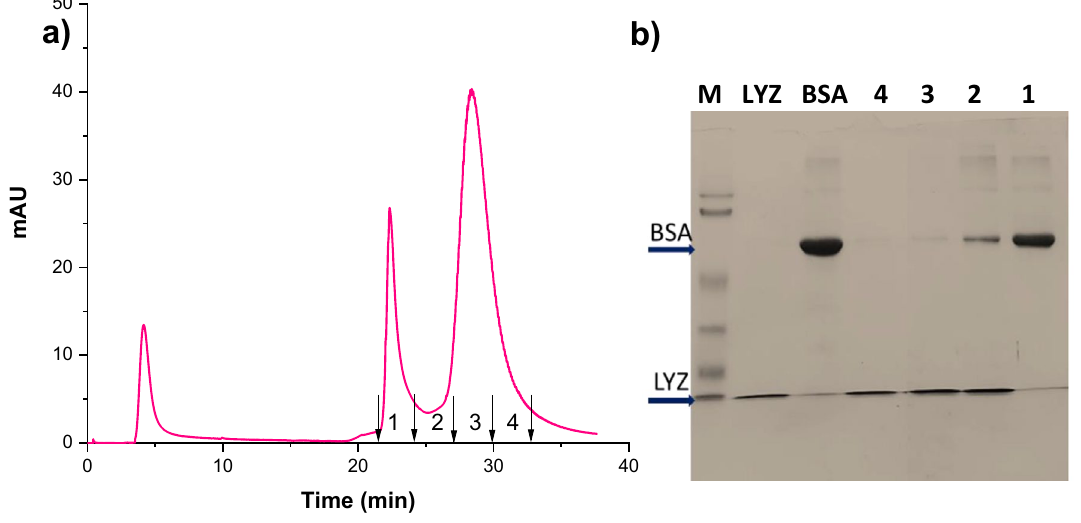
Figure 8. Isocratic elution chromatogram for the binary protein mixture of BSA and LYZ ( a ), SDS-PAGE cropped image obtained for collected fractions with marker and standard proteins ( b ).